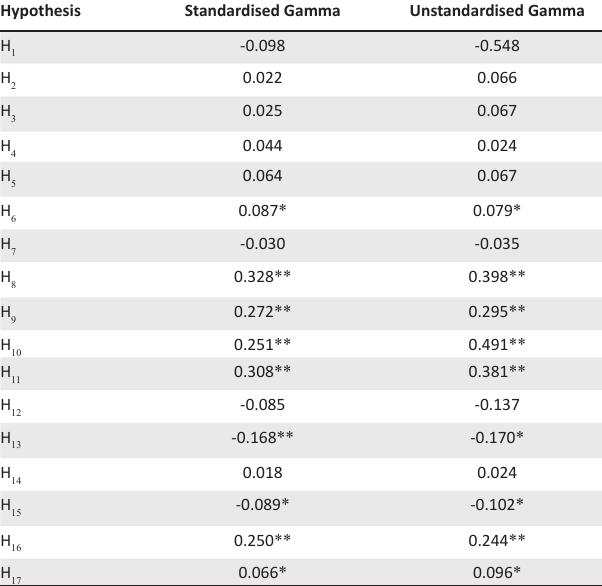
TABLE 7: Gamma parameters for the proposed structural equation modelling theoretical model. Hypothesis